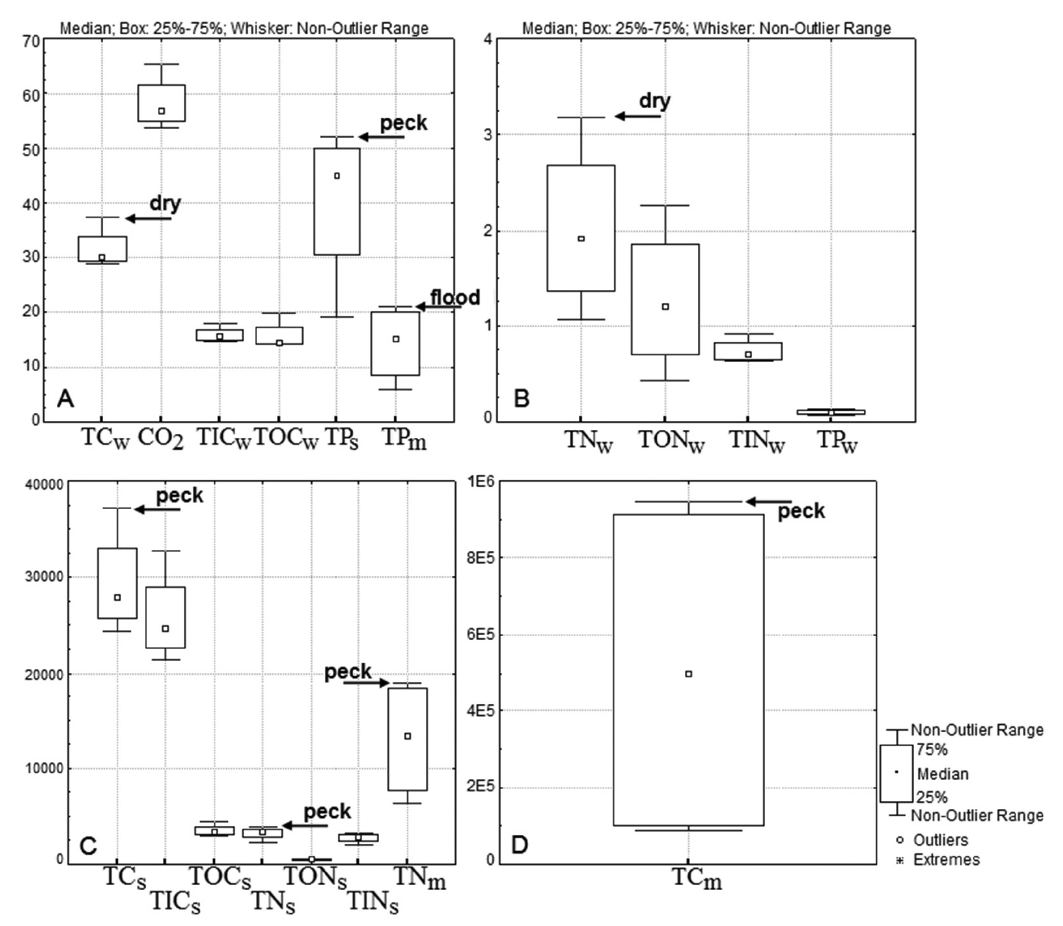
Figure 5. Boxplots for the compartments water (X medium and minimum of C, N and P in its various forms over the Catalão